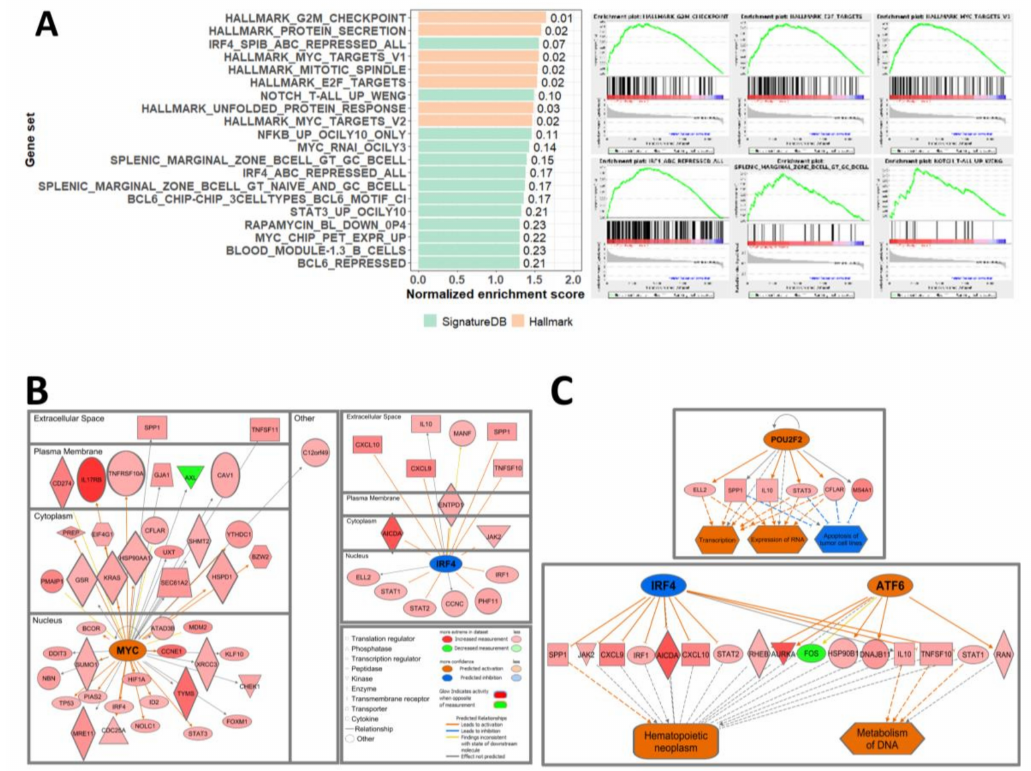
Figure 4. Gene set enrichment analysis (GSEA) and network analysis of NMZL samples compared to non-neoplastic LNs. ( A ) Significantly enriched gene sets in NMZLs and their normalized enrichment score (NES) are plotted. False discovery rate (FDR) q -values are shown to the right side of the bars (left). Representative enrichment plots of key gene sets are shown (right). ( B ) Mechanistic networks for the key upstream regulators MYC and IRF4 are shown. ( C ) IRF4 and ATF6 were predicted to cooperate, resulting in altered DNA metabolism and development of hematopoietic neoplasm, according to regulator e ff ect analysis, and the B-cell-specific TF POU2F2 was implicated in transcription and inhibition of